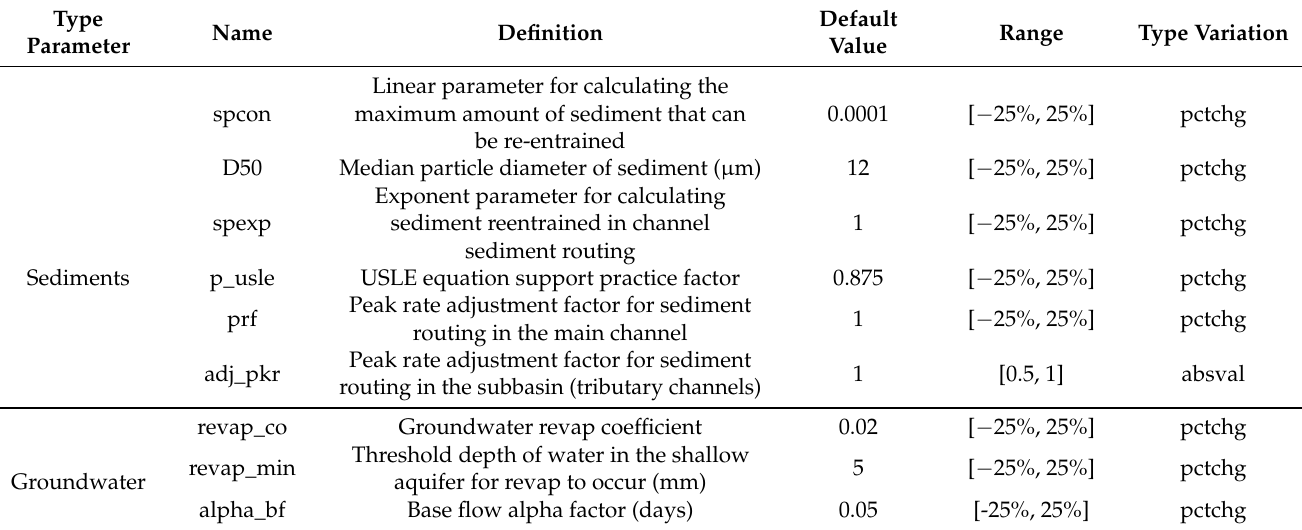
Table 5. Hydrological parameters, corresponding support (i.e., range of variability), and type of variation used in the sensitivity